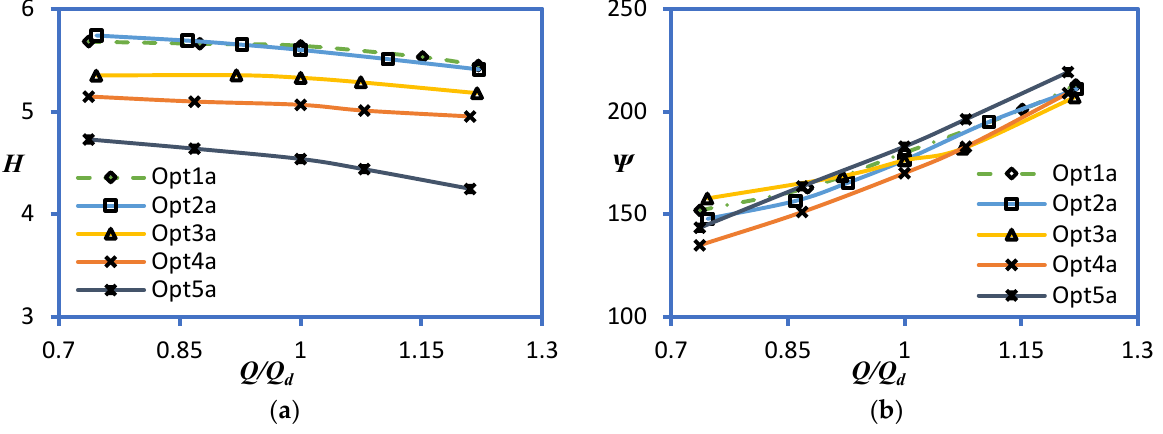
Figure 27. Effect of oil viscosity on the performance curves for optimized design of minimized input power: ( a ) head rise ( H ) vs. Q/Q d and ( b ) input power ( Ѱ ).